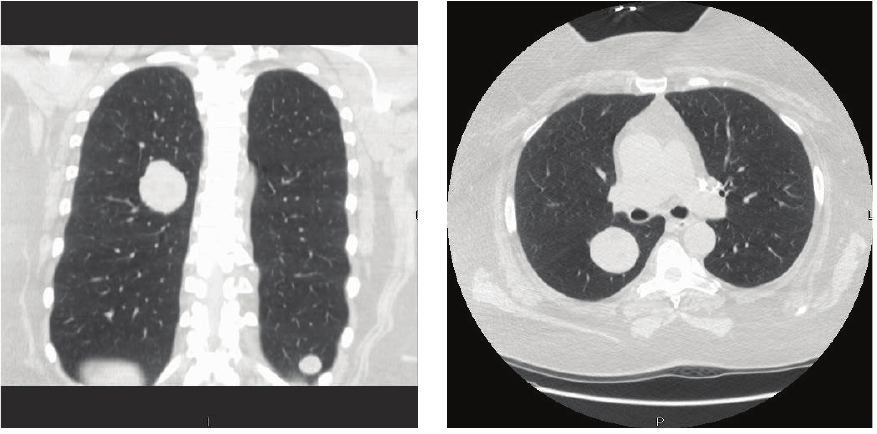
Figure 1: CT: well-defined noncalcified pulmonary